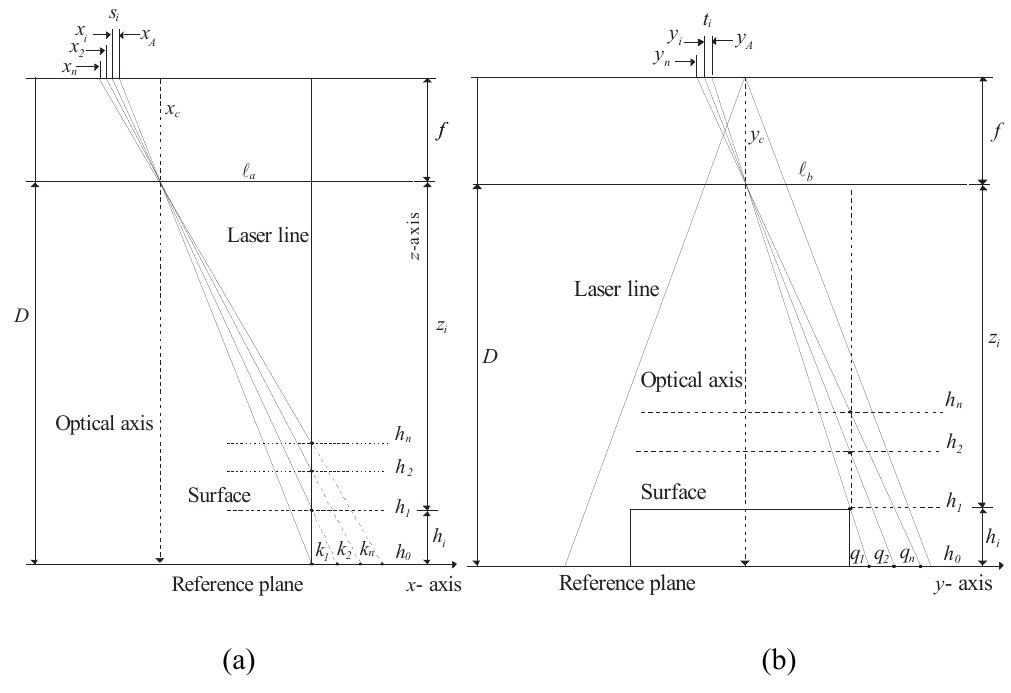
Figure 3. (a) Geometry of an image plane parallel to the reference plane in x -axis. (b) Geometry of an image plane parallel to the reference plane in y